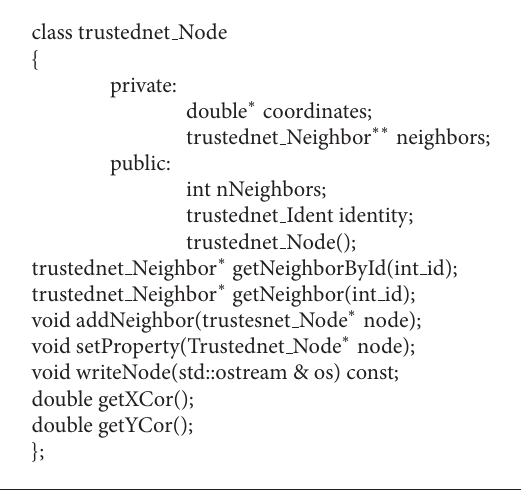
Algorithm 2: Program code of the class trustednet